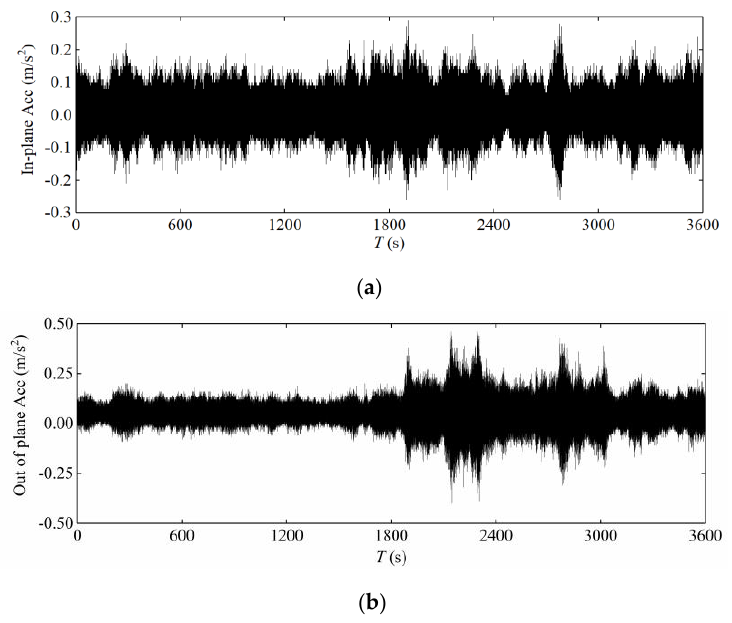
Figure 11. Measured acceleration of the upstream stay cable: ( a ) in plane; ( b ) out of plane.